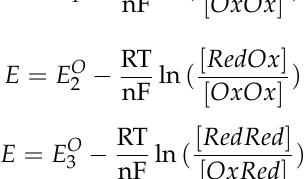
Scheme 5. Scheme showing the reactions in a simple two-step redox model. The doubly oxidised species OxOx can be reduced to OxRed with a redox potential of E O of E O . Ox Red and RedOx can then be further reduced to RedRed with redox potentials of E O 2 E O , 4